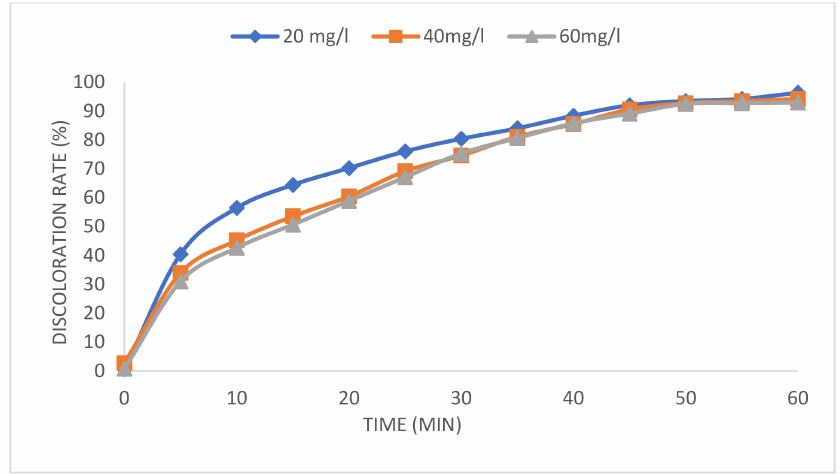
Figure 4. Effect of initial dye concentration on discoloration rate. Reaction condition: 50 mM Na 2 SO 4 , I C = 100 mA, pH = 3, 0.2 mM Fe 2+ , [H 2 O 2 ] = 8.8 mM, and T = 30 ± 0.1 ◦